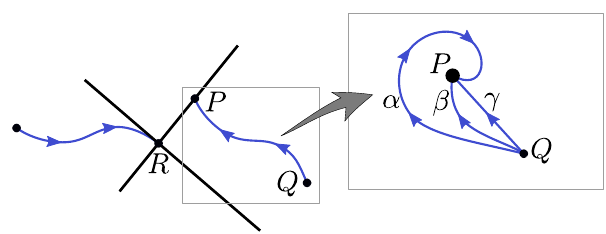
Figure 2 . Sketch of di(cid:11)erent trajectories in the moduli space. The straight black lines correspond to singular divisors, while the blue lines correspond to di(cid:11)erent type of trajectories approaching the singular loci. The left (cid:12)gure refers to whether the trajectory is approaching a one-parameter (point P ) or a multi-parameter degeneration (point R ). Notice that, even if each singular divisor has one transverse complex coordinate T i , the left drawing corresponds to the plane spanned only by the two real components (cid:30) i . The right (cid:12)gure corresponds instead to the complex plane spanned by T 1 = (cid:30) 1 + i(cid:18) 1 . It can be therefore seen as a transversal view of the left (cid:12)gure so that one of the singular divisors appears as a point. Di(cid:11)erent trajectories (cid:11); (cid:12); (cid:13) correspond to di(cid:11)erent mixings of the saxion (cid:30) 1 with the axionic (cid:12)eld (cid:18) 1 , so that (cid:13) is a purely saxionic